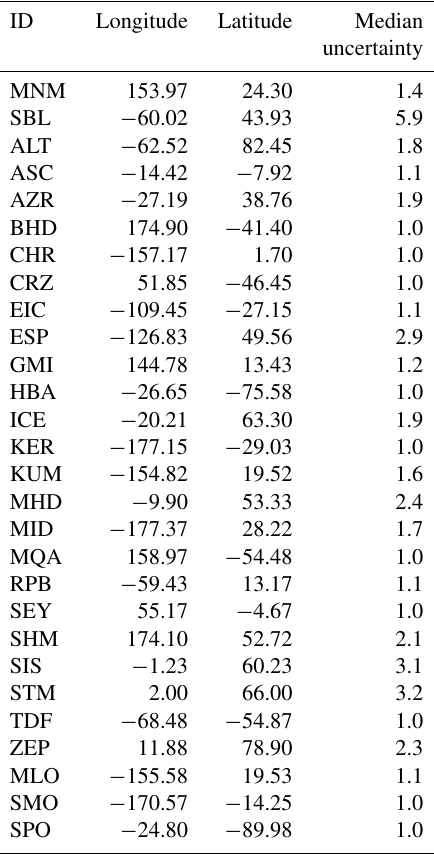
Table B1. CO 2 stations used in the assimilation together with their median uncertainty.